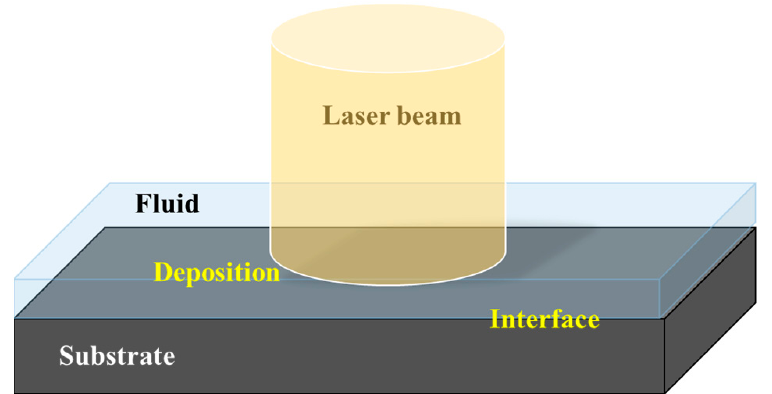
Figure 1. Schematic diagram of laser induced deposition. Table 1. Values of different governing